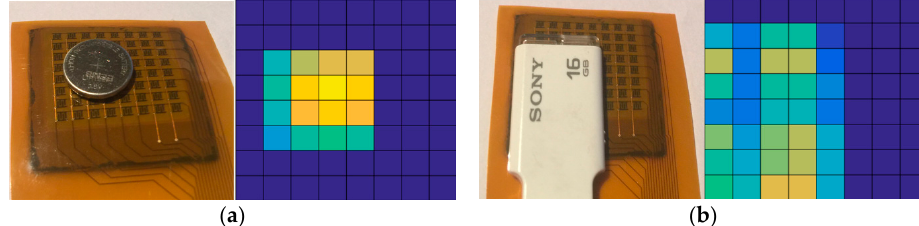
Figure 13. ( a ) Pressing test with a button battery and its corresponding force image; ( b ) Pressing test with a USB drive and its corresponding force image.